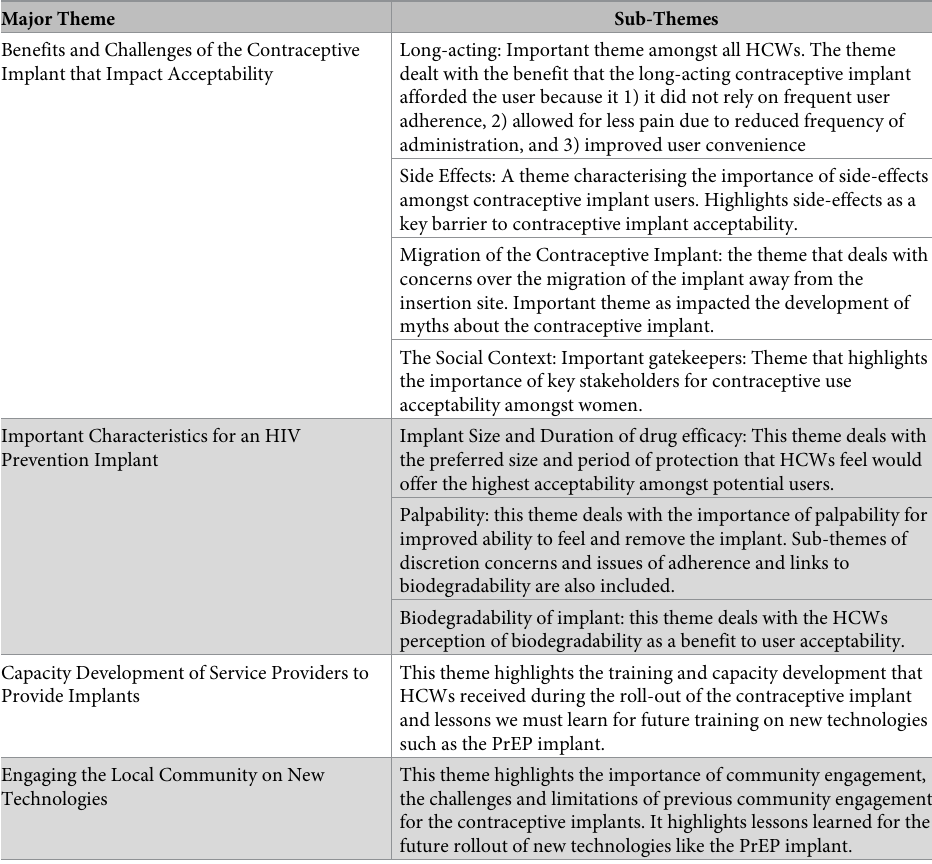
Table 2. Outline of major themes identified during